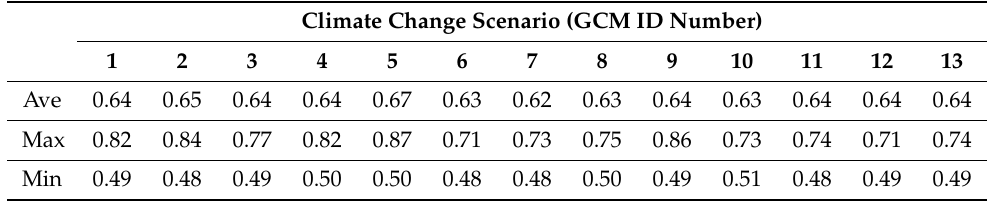
Table 3. Hydrologic risks of the 100-year flood according to the RCP 8.5 (Total Period). Climate Change Scenario (GCM ID Number)